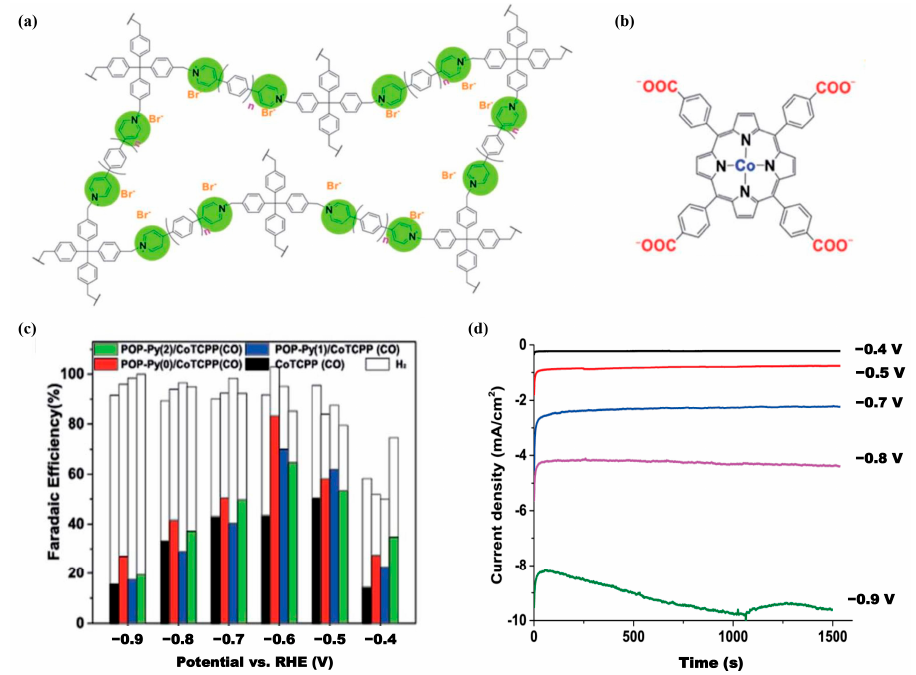
Figure 3. ( a ) The structure of POP − Py (n). ( b ) The structure of CoTCPP. ( c ) Faradaic efficiencies for carbon monoxide and hydrogen production on CoTCPP and POP − Py(n)/CoTCPP. ( d ) Representative chronoamperograms of CO 2 electroreduction catalyzed by POP − Py(2)/CoTCPP at various potentials in a 0.5 M KHCO 3 aqueous solution [49]. Reprinted with permission from Ref. [49]. Copyright 2020, Royal Society of Chemical (London, UK).